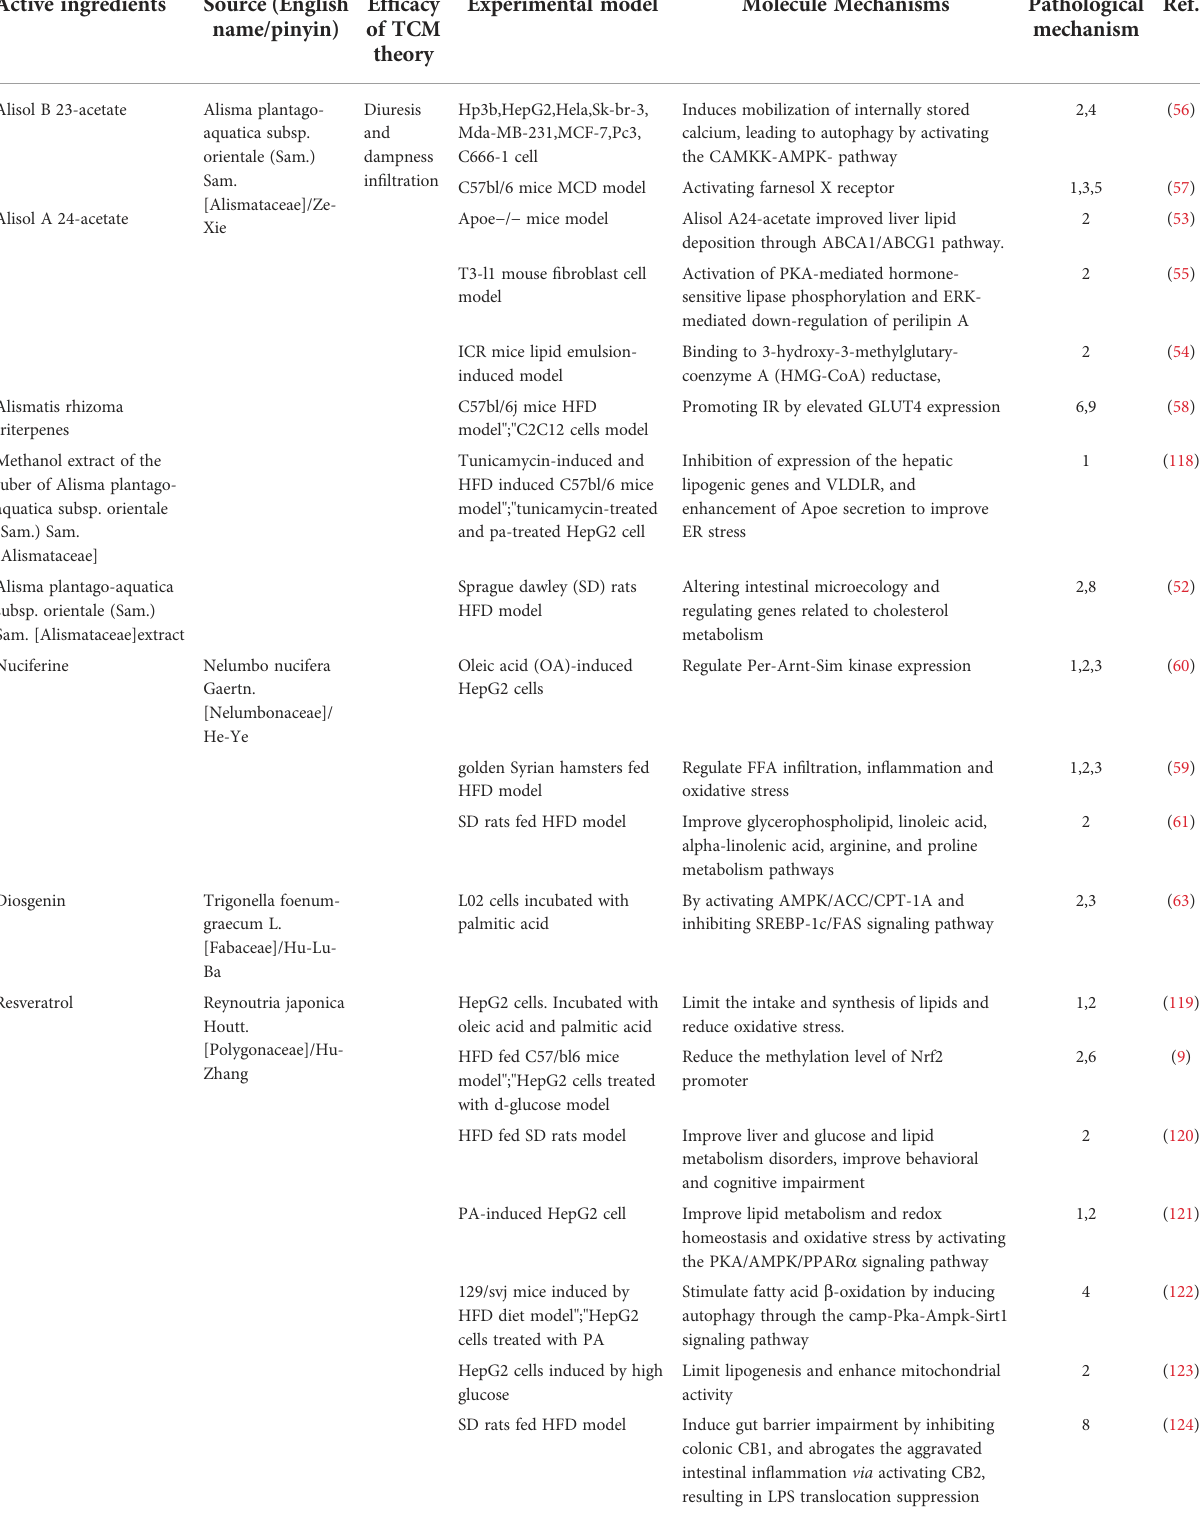
TABLE 2 Main mechanisms of CHM treating Congestion of Dampness Turbidity of NAFLD and its complications by dispelling dampness (Qu Shi) and dissolving turbidity (Hua Zhuo). Active